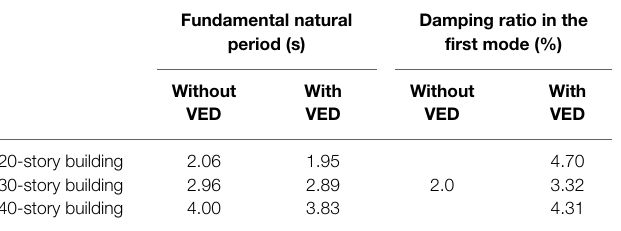
TABLE 3 | Fundamental natural period and damping factor of buildings with and without VED .